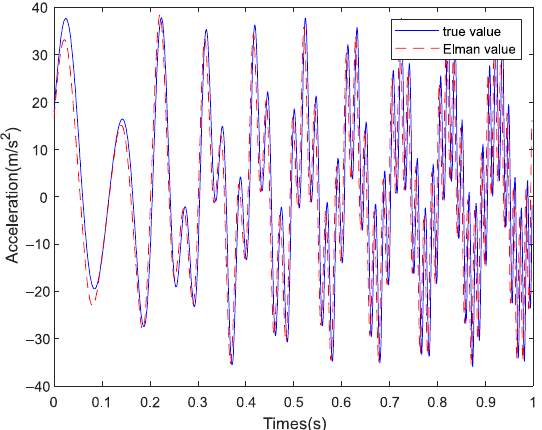
Figure 17. Reconstruction result after IEMD decomposition.